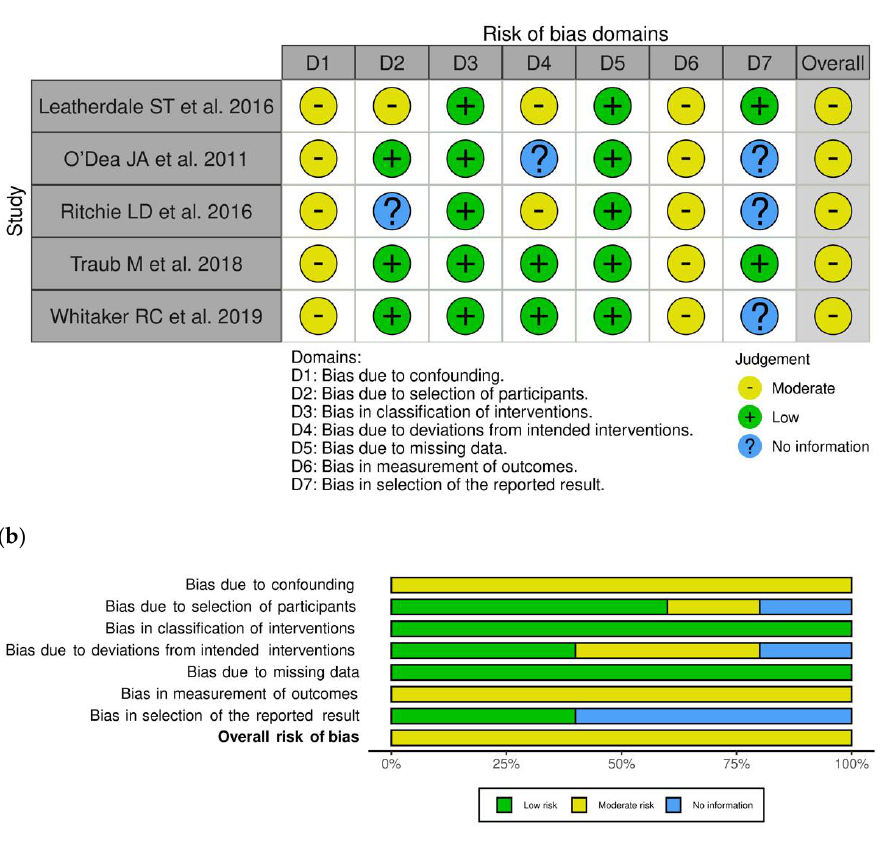
Figure 2. Risk of bias within longitudinal studies. ( a ) Traffic light plot and ( b ) summary plot pre- senting the risk of bias within the longitudinal studies included in the systematic